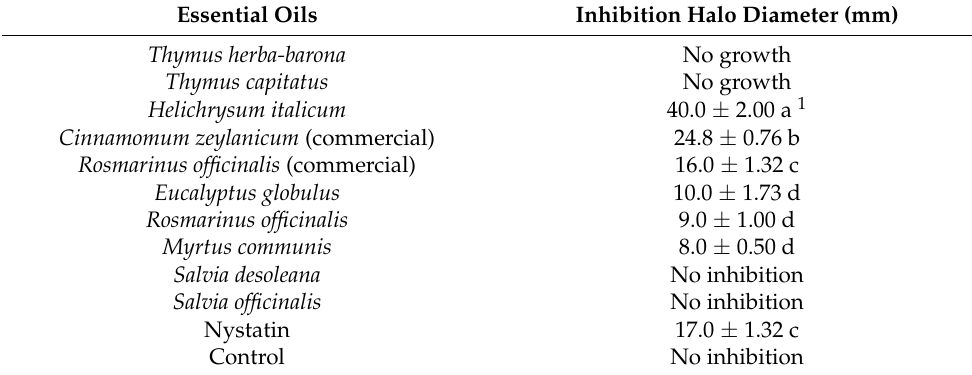
Table 1. Inhibition halo diameter (mean ± SD) of pure essential oils on Ascosphaera apis using the paper disc agar diffusion